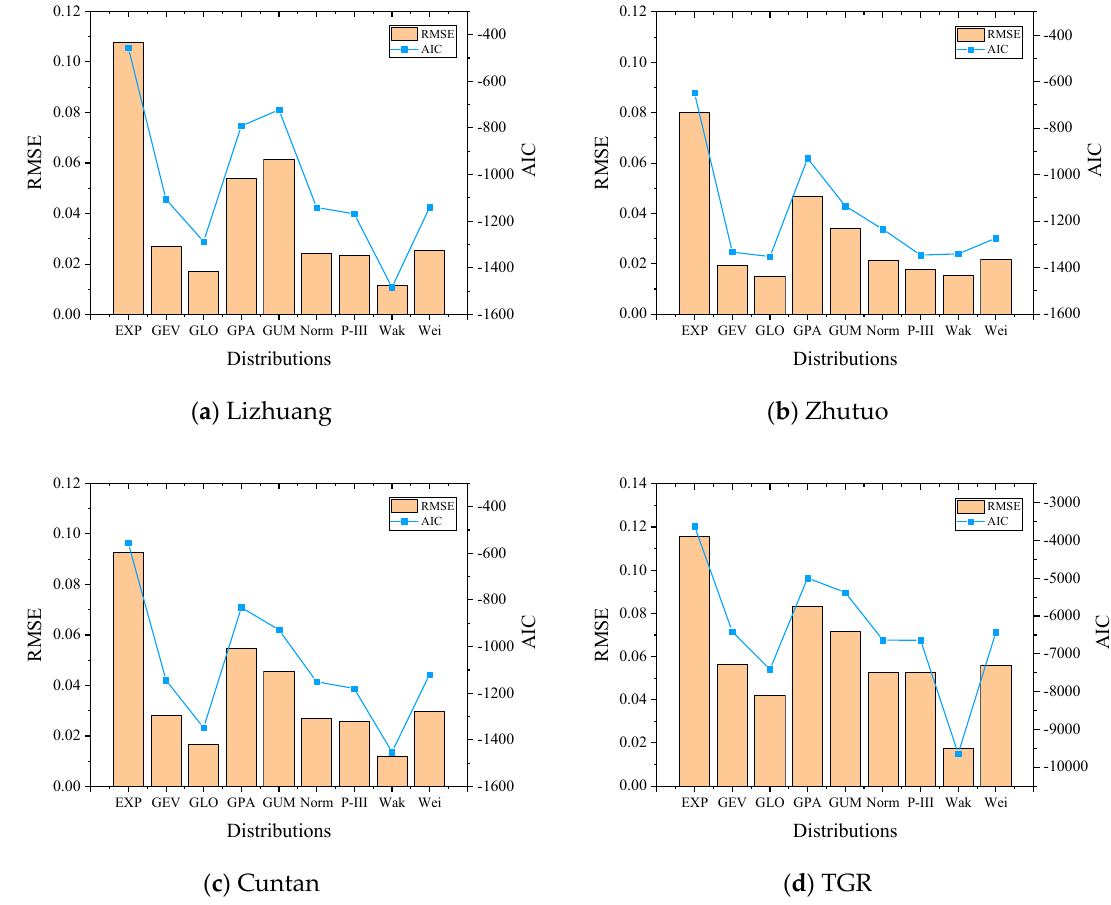
Figure 3. Test results of fitting flood forecasting errors with different distributions (Notes: The Wak and Wei in the picture represent the Wakeby distribution and Weibull distribution respectively). Table 2. Estimated parameters of distributions of flood forecast uncertainties.